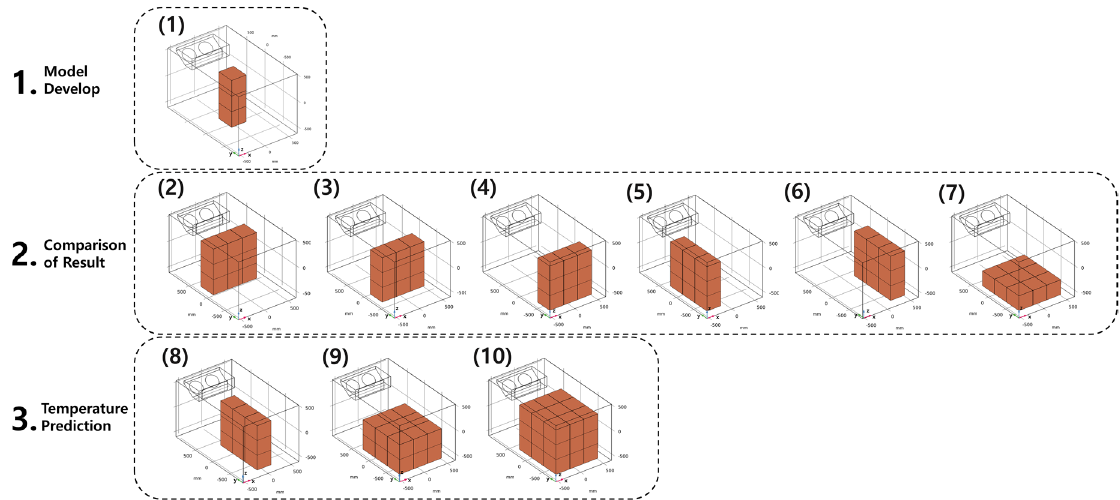
Figure 2. Box loading patterns used in experiments and numerical